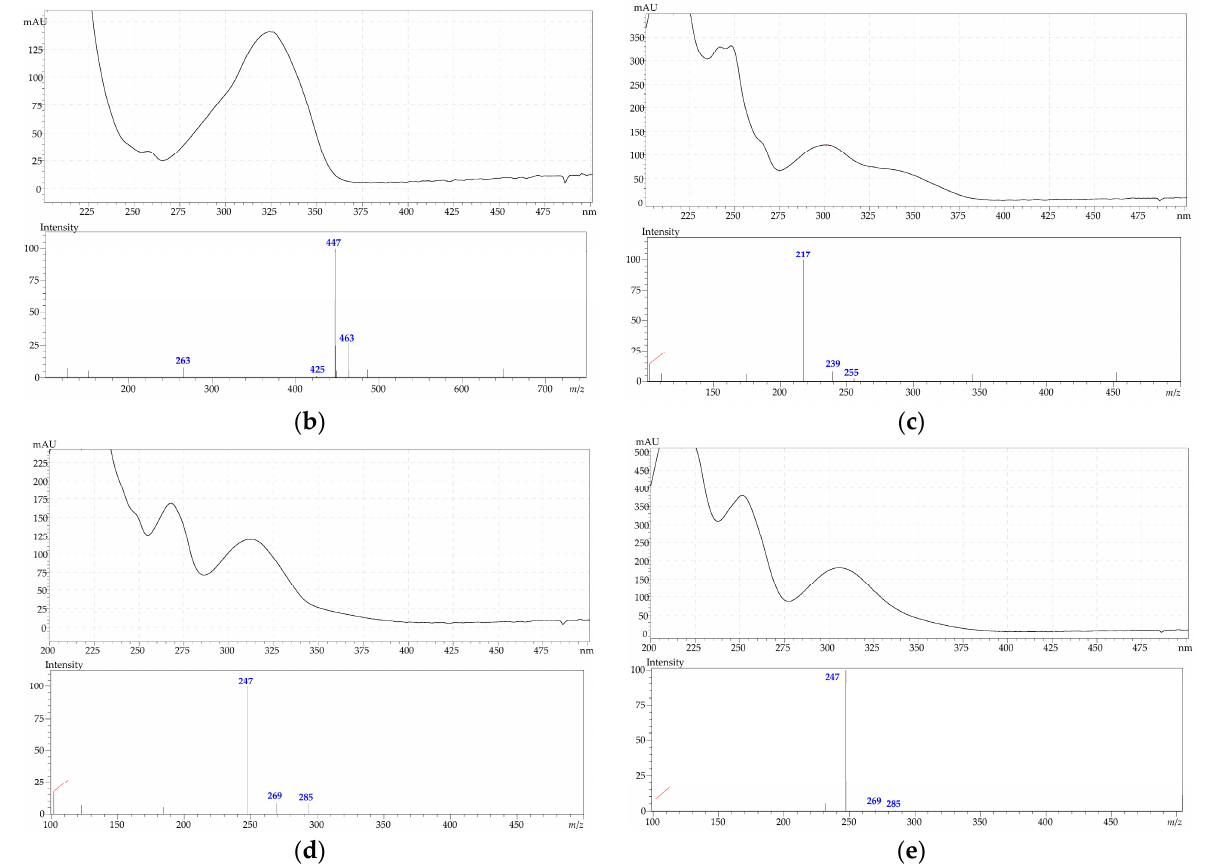
Figure 1. ( a ) High-performance liquid chromatography with electrospray ionization triple quadrupole mass spectrometric detection chromatogram (base peak intensity chromatogram, positive ionization; MS: TIC) and photodiode array detection at 310 nm (PDA: 310 nm) chromatograms of an extract of L. officinale fresh roots (cv. Lider). ( b ) UV and mass spectra of principal coumarins: apterin ( b ), xanthotoxin ( c ), isopimpinellin ( d ), and pimpinellin ( e ). Compounds are numbered as listed in Table